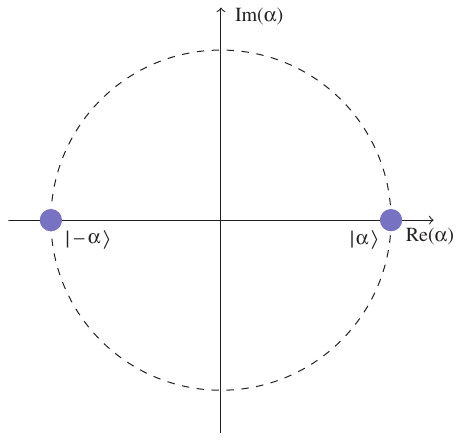
Figure 5: Coherent state encoding as a superposition of two coherent